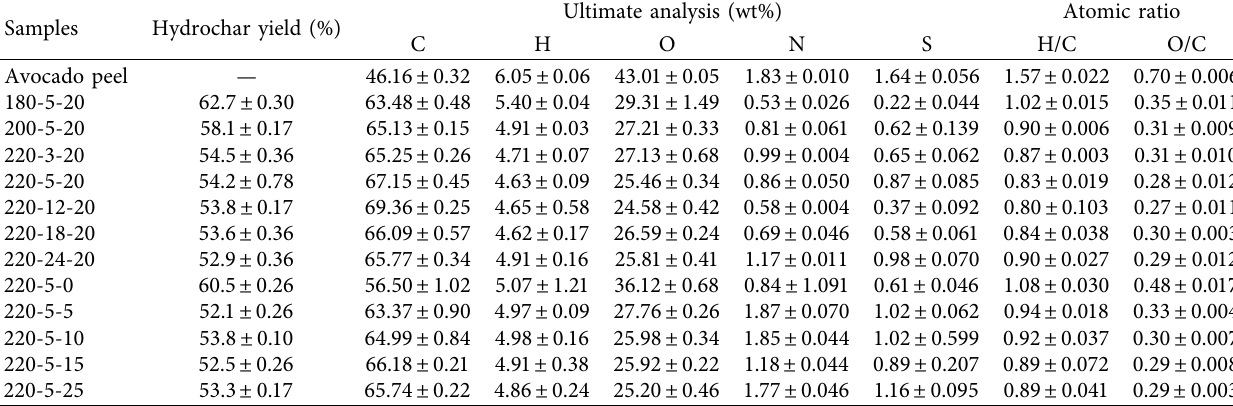
Table 1: Hydrochar yield and elemental analysis of feedstock and different hydrochars. Samples Hydrochar yield (%)